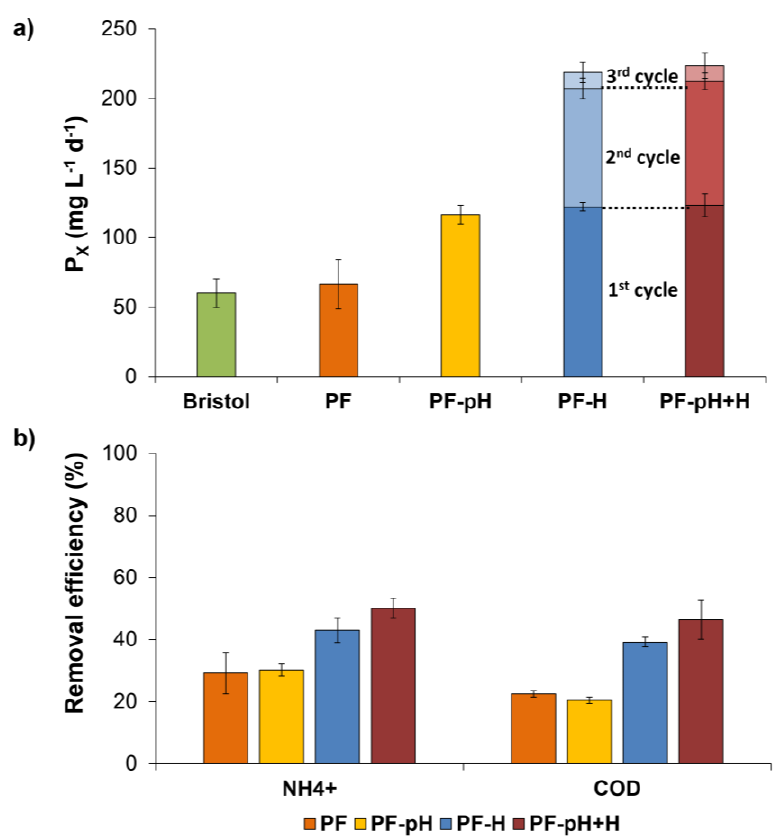
Figure 8. ( a ) Average biomass productivity and ( b ) removal efficiencies of ammonia (NH 4+ ) and chemical oxygen demand (COD) after growth of Tetradesmus obliquus grown in piggery wastewater pre-treated by Photo-Fenton with combined optimization strategies (PF: no pH control or weekly harvesting; PF-pH: only pH control; PF-H: only weekly harvesting; PF-pH+H: pH control and weekly harvesting). Bristol medium was used as the control. Values are presented as the mean ± mean deviation ( n = 2).